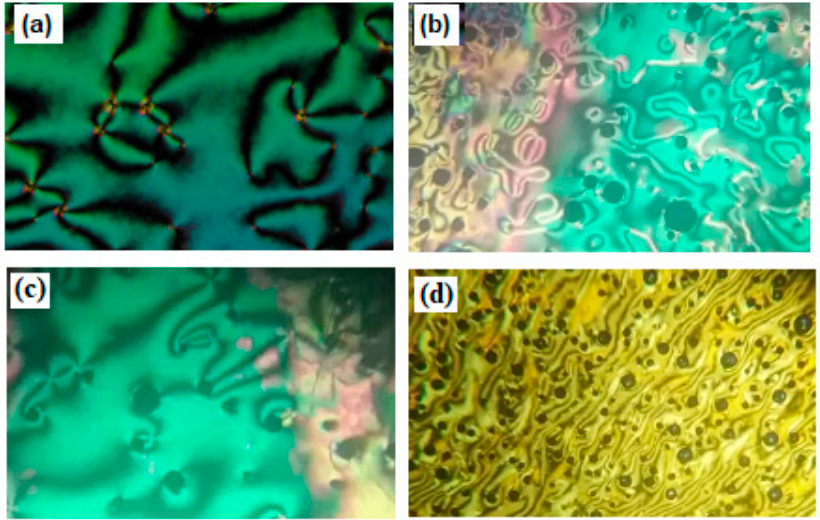
Figure 3. Nematic phase textures observed under POM for ( a ) compound I6 a at 131.0 °C upon heating; ( b ) compound I6 d at 125.0 °C upon heating; ( c ) compound I6 d at 100.0 °C upon cooling;